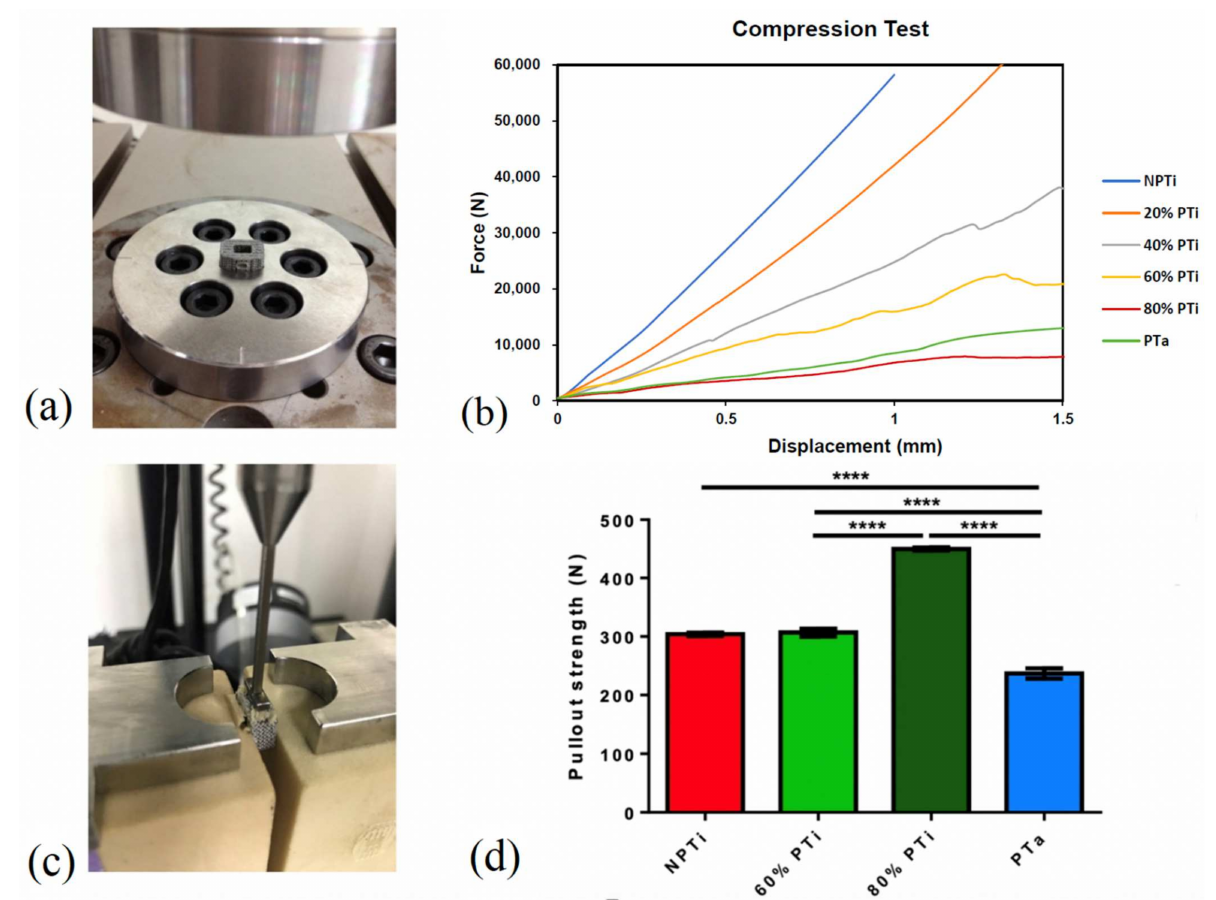
Figure 4. ( a ) Compression test model for nonporous titanium (NPTi), porous titanium (PTi) and porous tantalum (PTa) cages. ( b ) Compression test results for each cage, ( n = 5). ( c ) Pullout test model for cages. ( d ) Pullout strength test results for NPTi, 60% PTi, 80% PTi, and PTa cages ( n = 5). **** p <